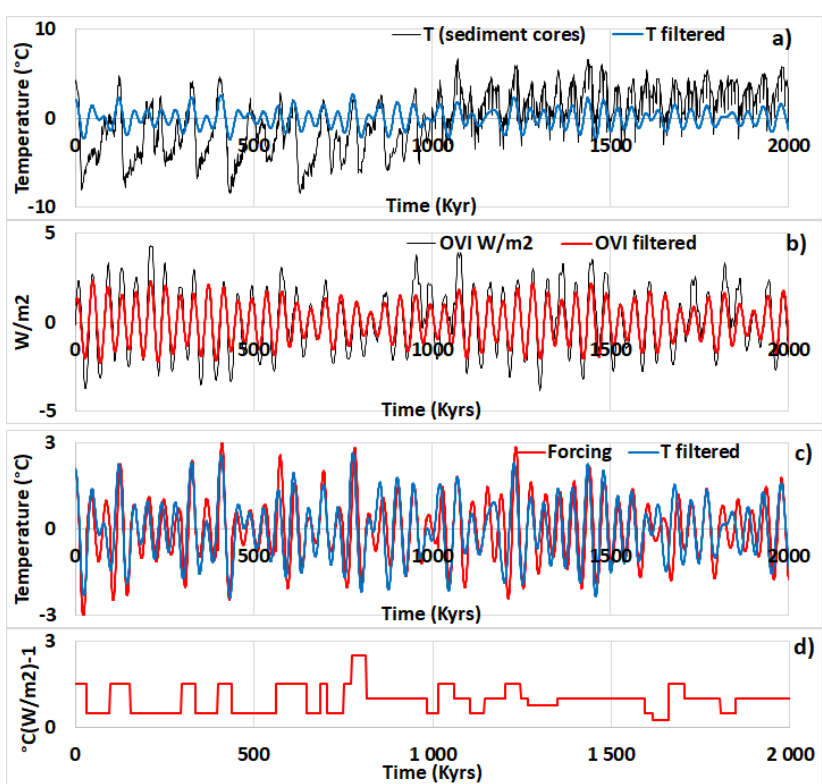
Figure 9. Impact of the eccentricity on the Gyral Rossby Waves (GRWs) into the band 73.7 – 147.4 K yrs; ( a ) Global mean temperature estimated from foraminifera in sediment cores; ( b ) Orbital Variations of Insolation (OVI); ( c ) Comparison of the OVI multiplied by the forcing efficiency and the global mean temperature; ( d ) the forcing efficiency.